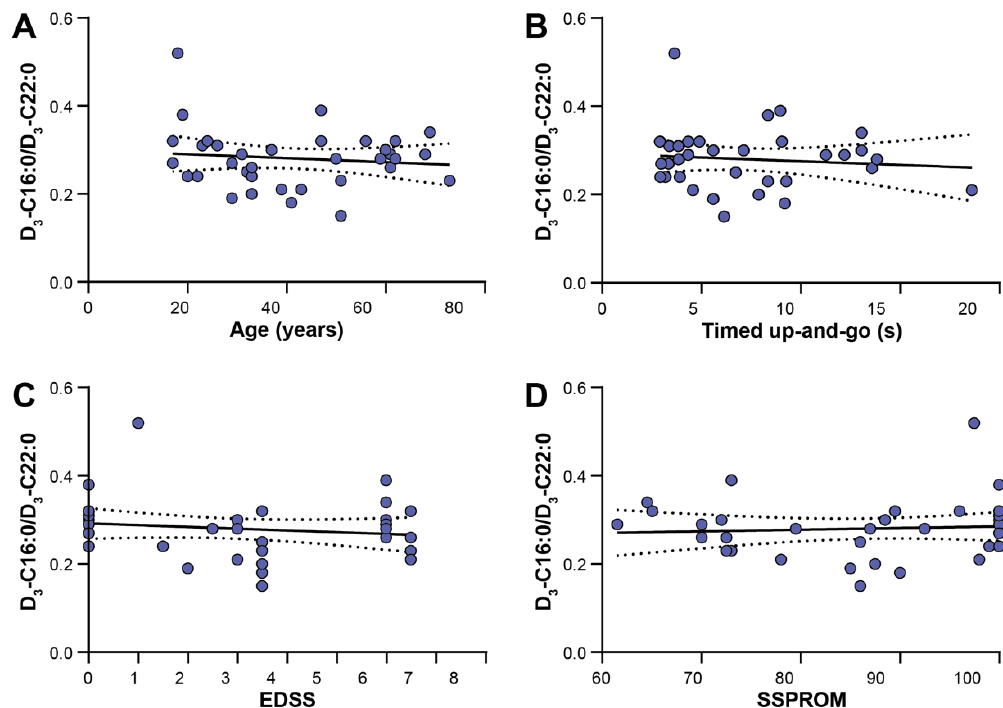
Figure 3. Scatter dot plots show the absence of correlations between clinical characteristics and residual peroxisomal ß-oxidation capacities (D 3 -C16:0/D 3 -C22:0 ratio). The lines represent simple linear regression lines with the 95% confidence interval. ( A ) Age, correlation coefficient − 0.125, p = 0.467; ( B ) Timed Up-and-Go, correlation coefficient − 0.092, p = 0.61; ( C ) EDSS (Expanded Disability Status Scale), correlation coefficient − 0.173, p = 0.314; ( D ) SSPROM (Severity Score system for Progressive Myelopathy), correlation coefficient 0.197, p = 0.249.